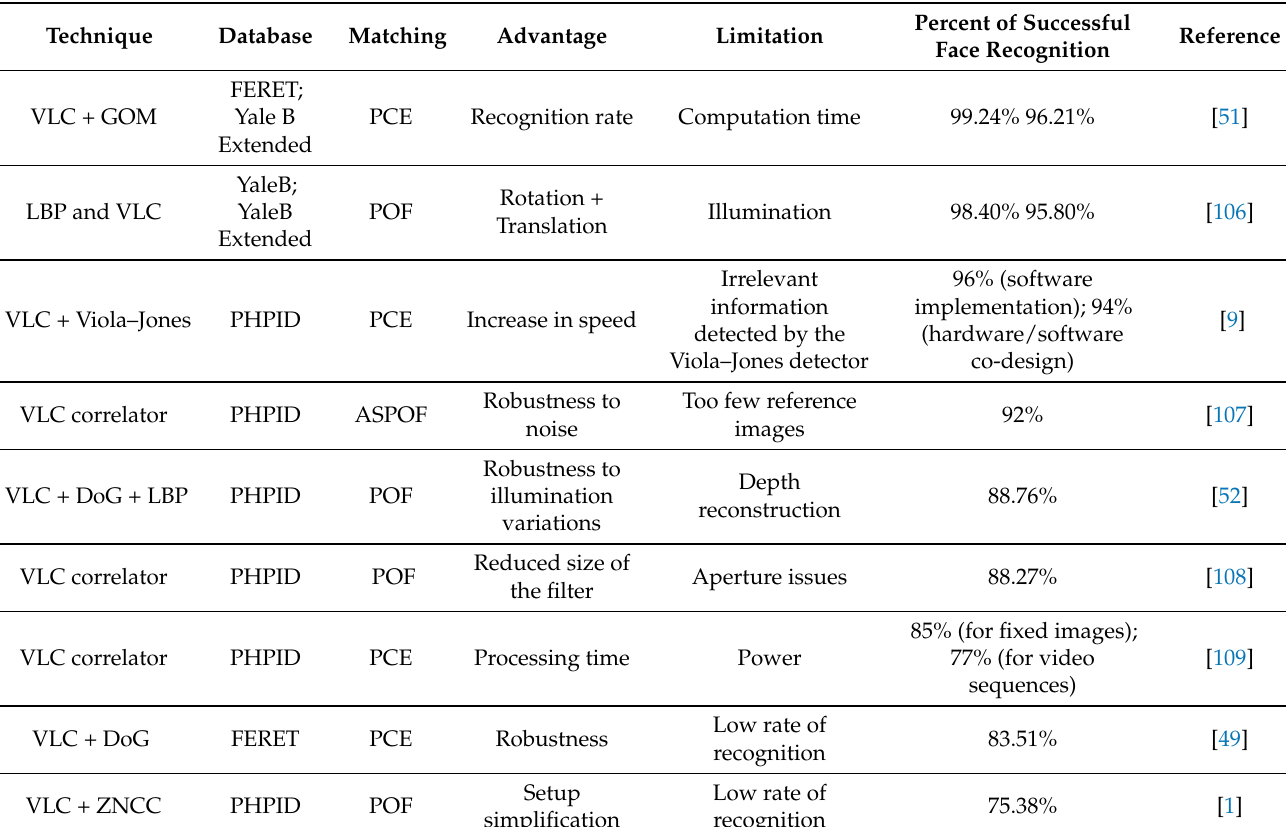
Table 6. Comparison between the most important characteristics of VLC techniques proposed for face recognition applications. I adapted the data from [9,20] and added new information. For an easier comparison of the results than in our early version [5], I now arranged the data in descending order of the percent of successful face